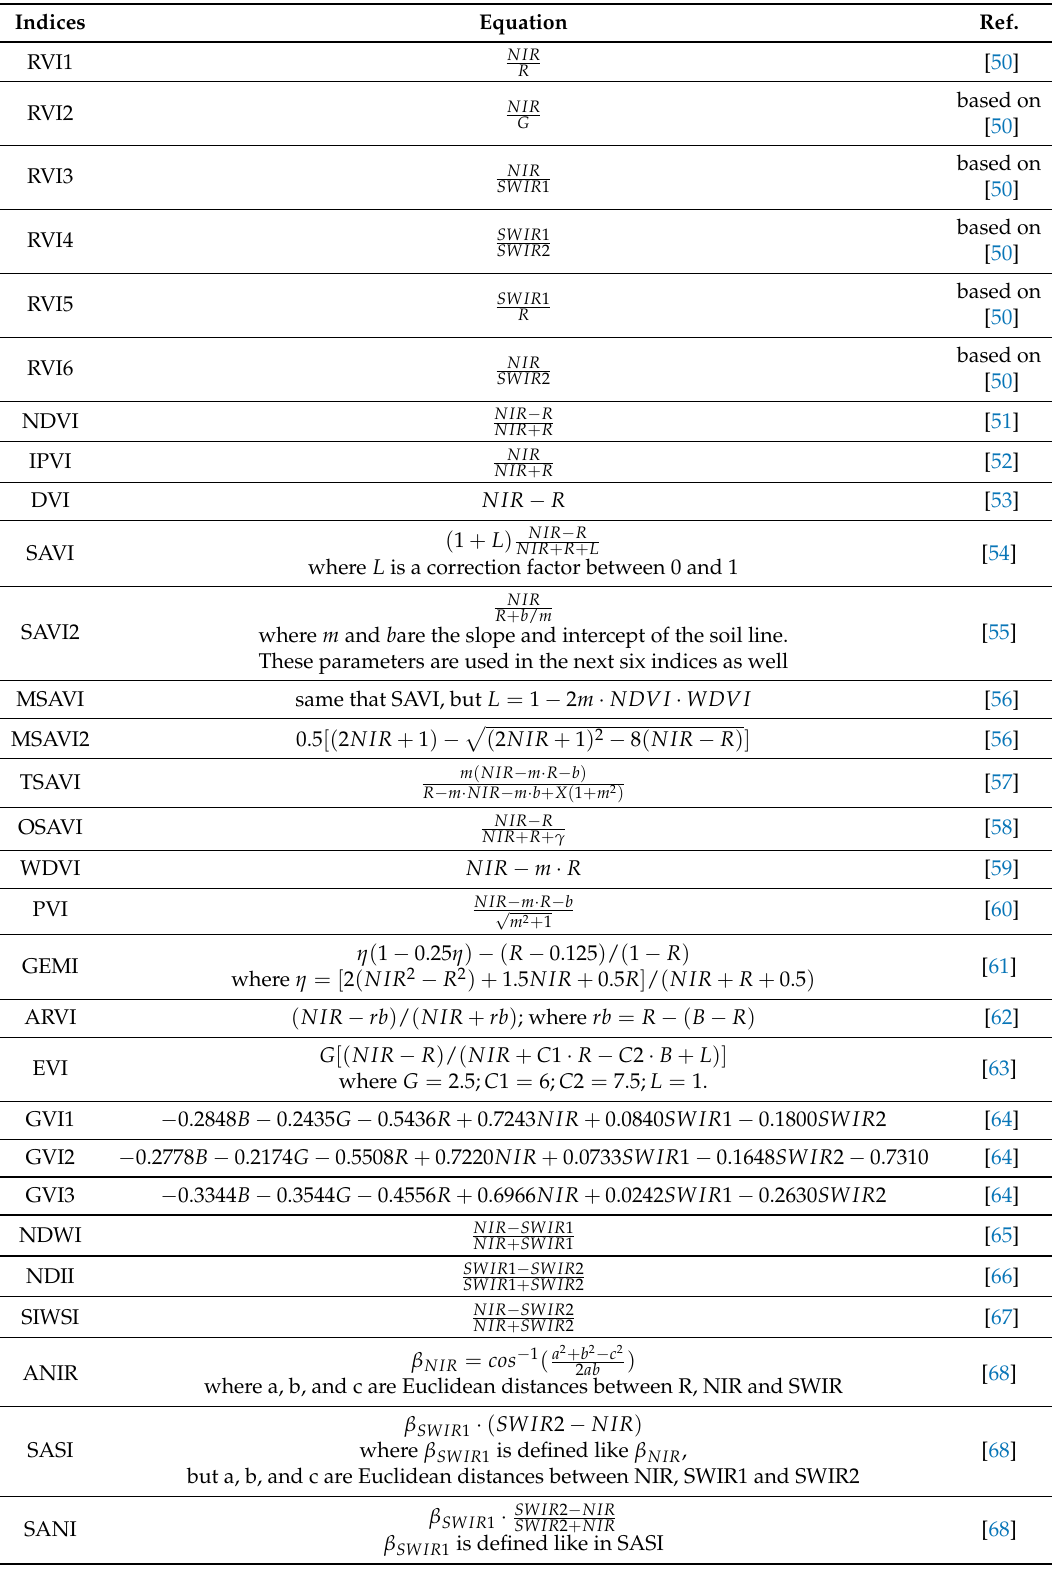
Table 2. The 30 most-employed VIs in the